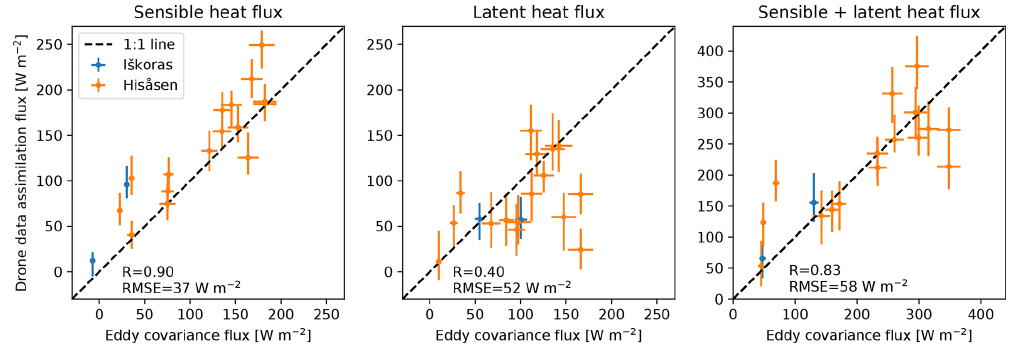
Figure 6. Comparison of flux estimates by EC towers and drone data assimilation, as estimated by posterior distributions of the ES-MDA method with two iterations, for a total of 18 separate flights at two different sites. Error bars for drone data assimilation fluxes indicate the interquartile range, and points indicate the median value. Error bars for EC fluxes indicate the random flux error estimated by